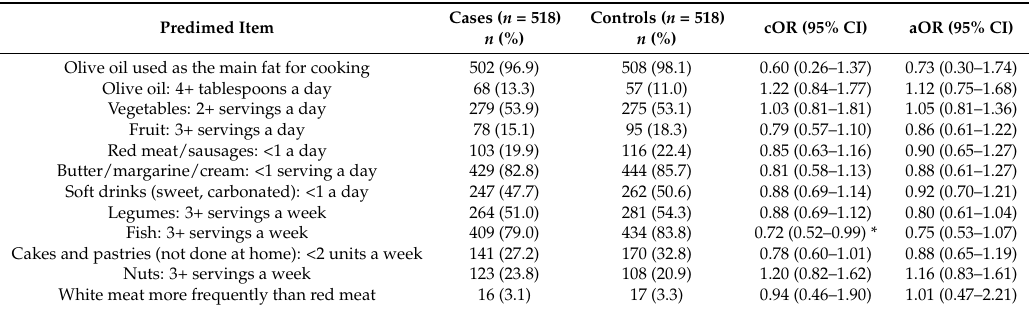
Table 2. Items of the PREDIMED score for adherence to Mediterranean diet and risk of Small for Gestational Age (SGA).